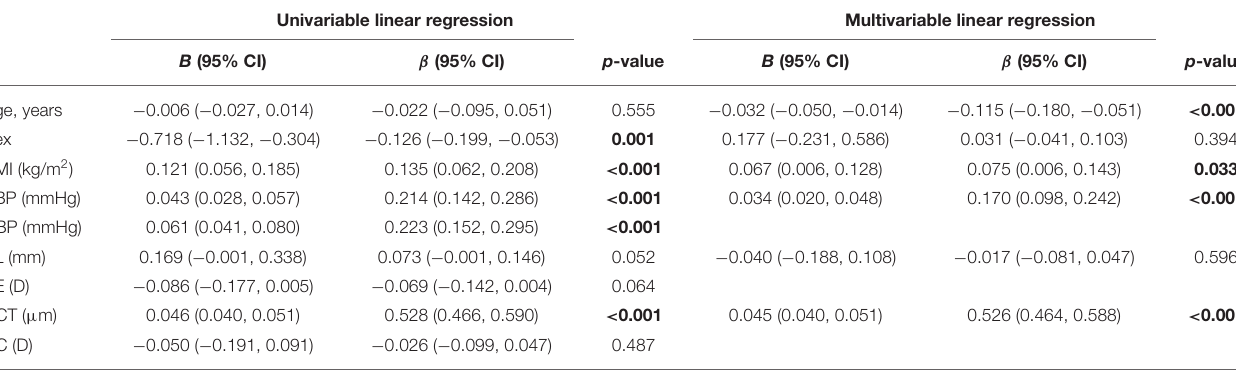
TABLE 2 | Univariate and multivariable linear regression analyses of factors that affect IOP NCT . Univariable linear regression Multivariable linear regression